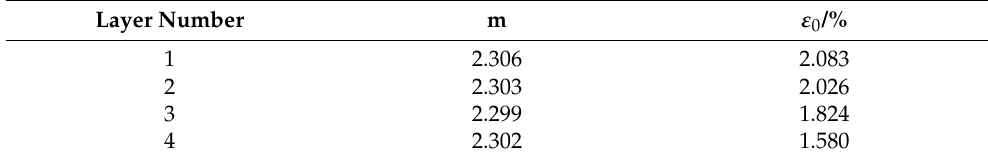
Table 7. Parameters of damage constitutive model.